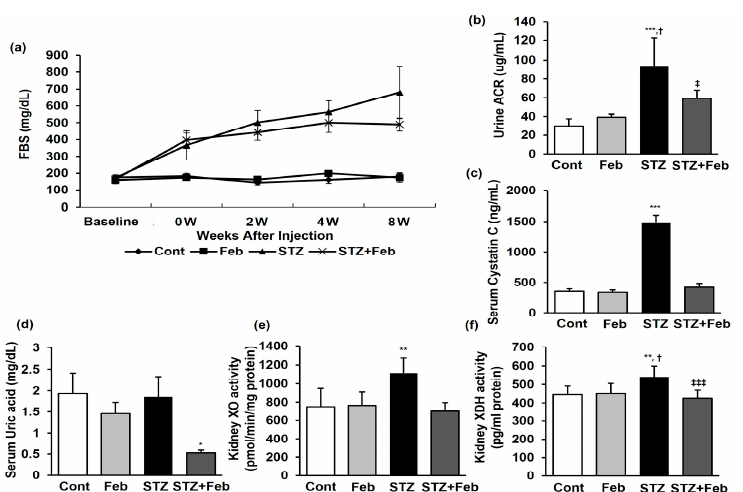
Figure 1. The changes in glucose, renal function, and XOR activities in STZ-induced diabetic mice with or without febuxostat treatment. ( a ) Fasting blood glucose, ( b ) Urine Albumin/Creatinine ratio, *** p < 0.001 vs. Cont, † p < 0.05 vs. Feb, and ‡ p < 0.05 vs. STZ group. ( c ) Serum cystatin C, *** p < 0.001 vs. other groups, ( d ) serum uric acid, * p < 0.05 vs. other groups, ( e ) kidney XO activity, ** p < 0.01 vs. other groups, ( f ) kidney XDH activity, ** p < 0.01 vs. Cont, † p < 0.05 vs. Feb, and ‡‡‡ p < 0.001